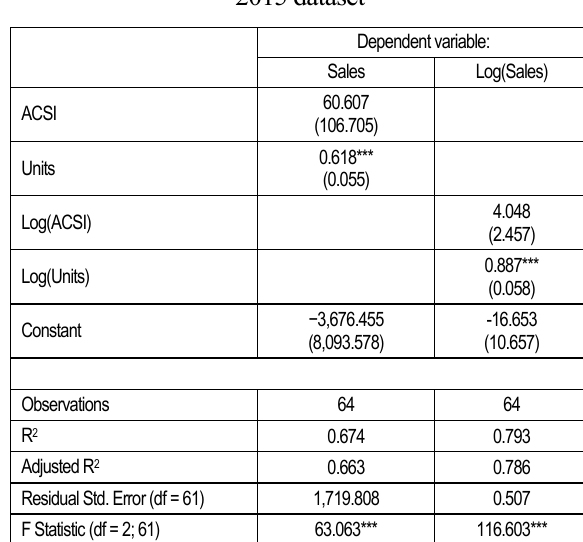
Table 8. OLS and log-log OLS models: